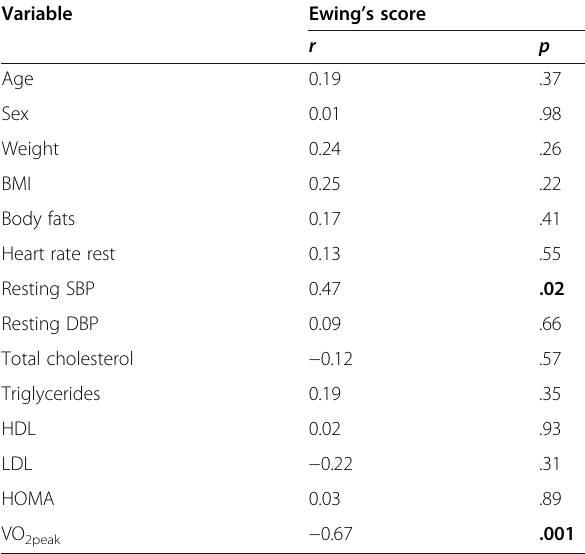
Table 3 Correlation of Ewing ’ s score with common CVD risk factors